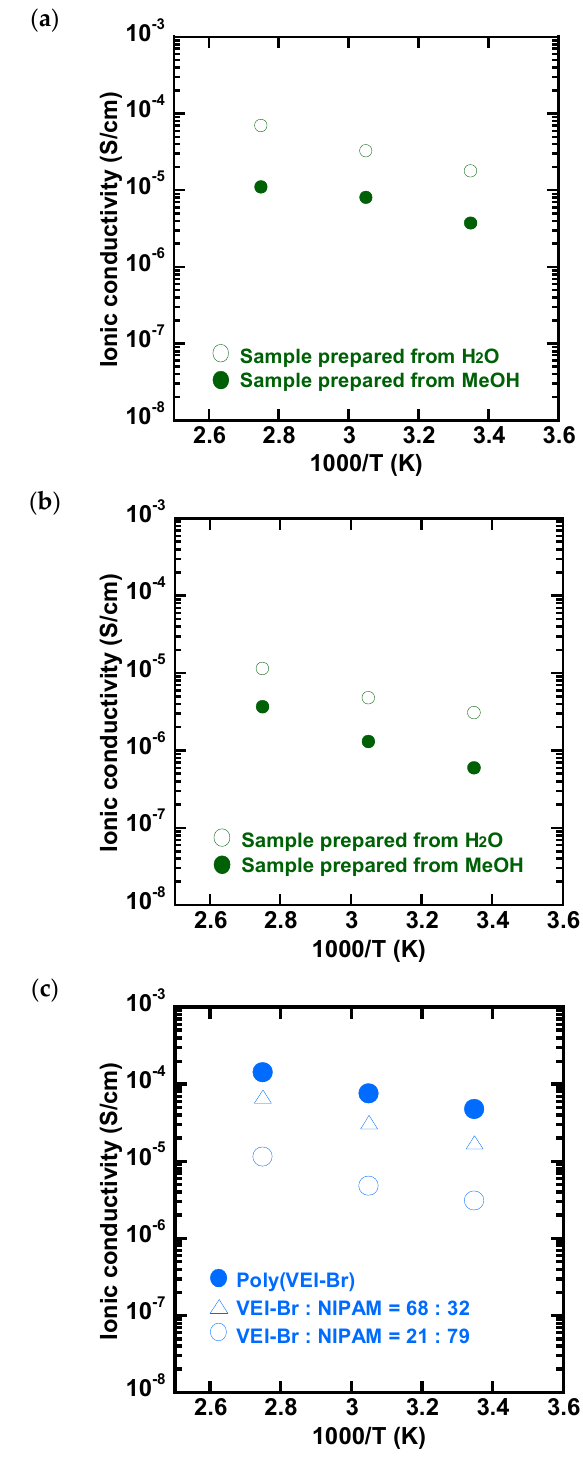
Figure 6. Preparation-dependent ionic conductivity of poly(NVI-Br)- b -poly(NIPAM)s; NVI-Br/NIPAM = ( a ) 68/32 and ( b ) 21/79. Hot aqueous and MeOH solutions of the block copolymers (40 °C) were cast onto a platinum electrode and dried at 40 °C for 2 h. ( c ) Temperature-dependent ionic conductivity of poly(NVI-Br)- b -poly(NIPAM)s having different comonomer compositions.